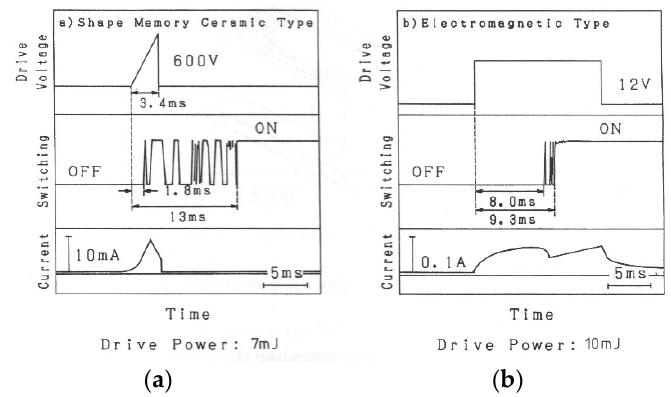
Figure 23. Dynamical response of the latching relay: ( a ) shape memory ceramic type; and ( b ) electromagnetic coil type.